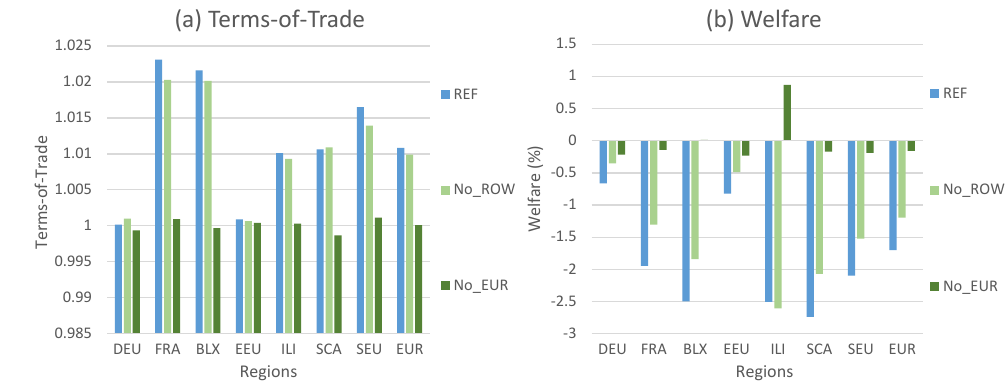
Figure 13. ToT and percentage change in welfare for different scenarios using the IEO